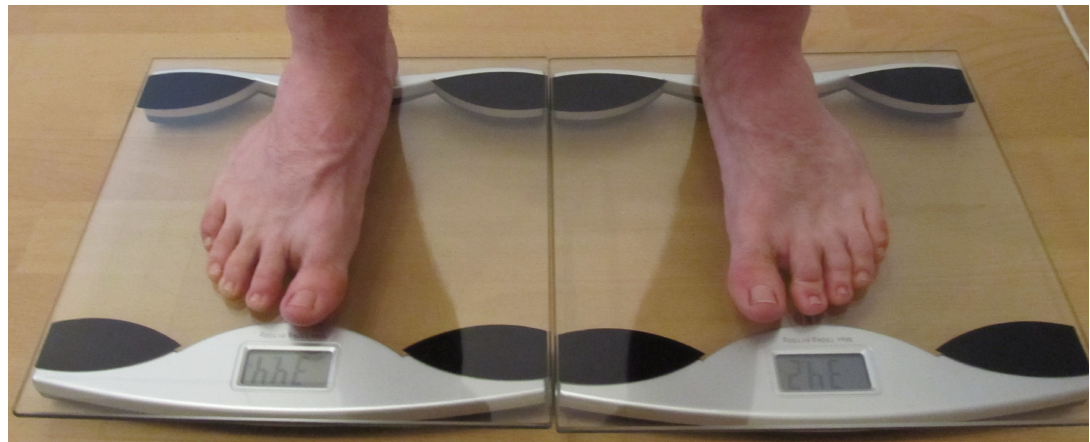
Figure 1. Measuring leg load distribution by using two equal commercial